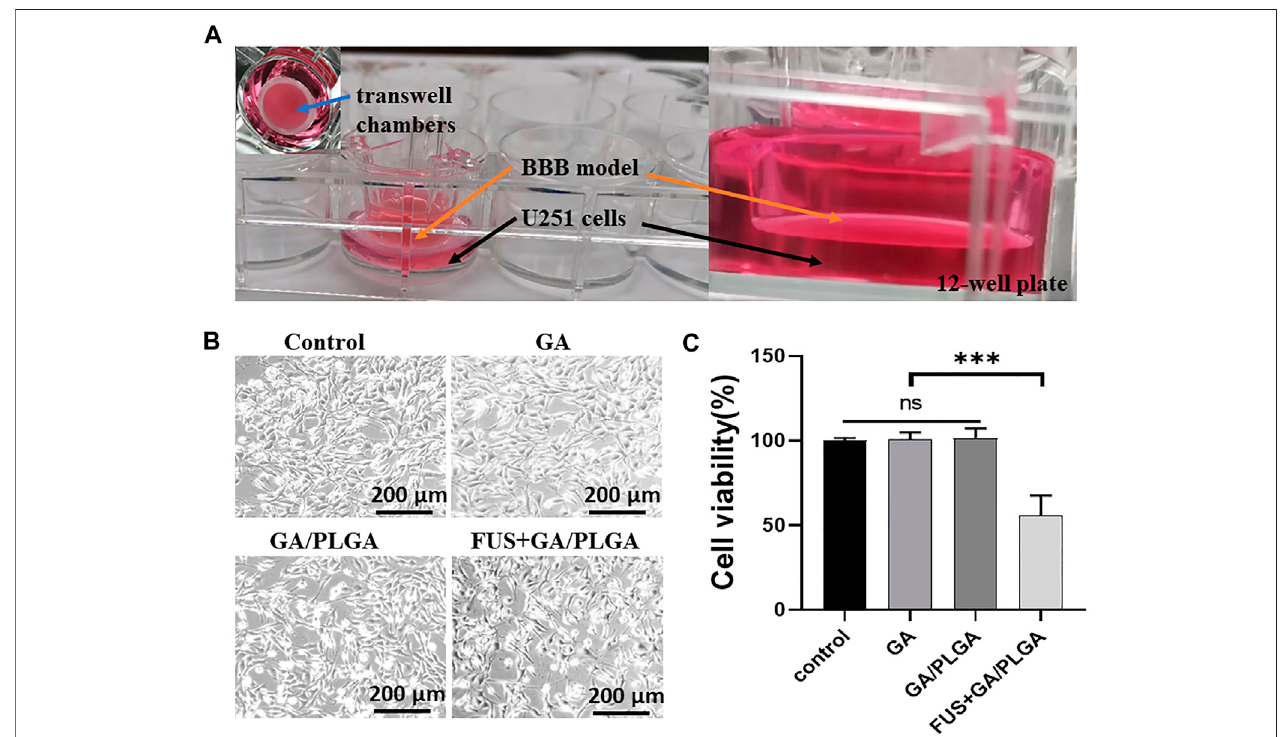
FIGURE7|(A) Construction ofthe invitro BBBmodel. bEnd3cellswereusedtobuildtheBBBmodel. (B) Afterfourdifferenttreatmentsfor24 h,thesurvivalstate of U251 cells in each group was observed under a microscope. (C) The cell viability of U251 cells in each group was detected by the CCK-8 reagent. The cell viability of the FUS + GA/PLGA group was 55.83 ± 10.99% (*** p < 0.001 versus the other